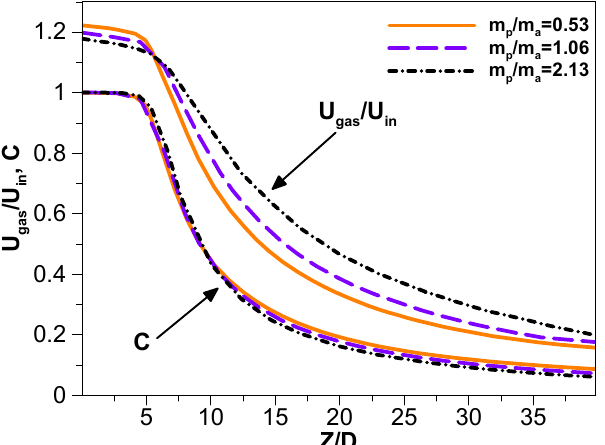
Figure 5. The effect of mass loading ratio on the velocity and tracer concentration decay rate on the trajectory of the gas-phase jet.